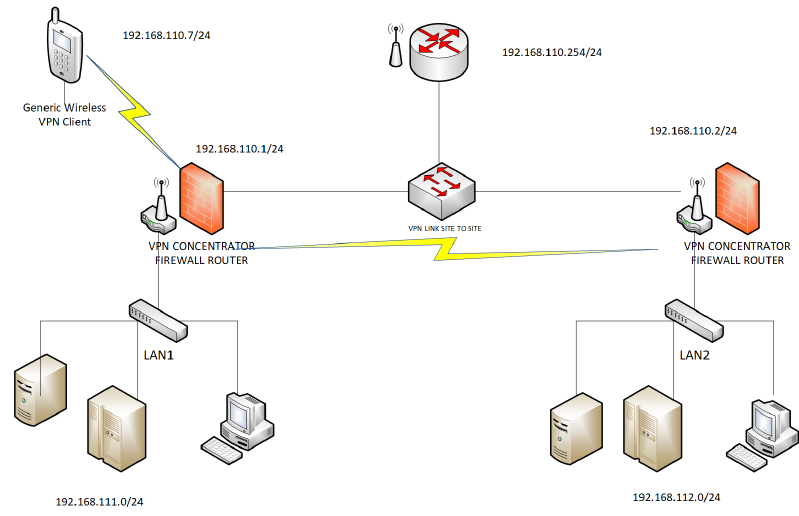
Figure 5. Generic VPN Deploy